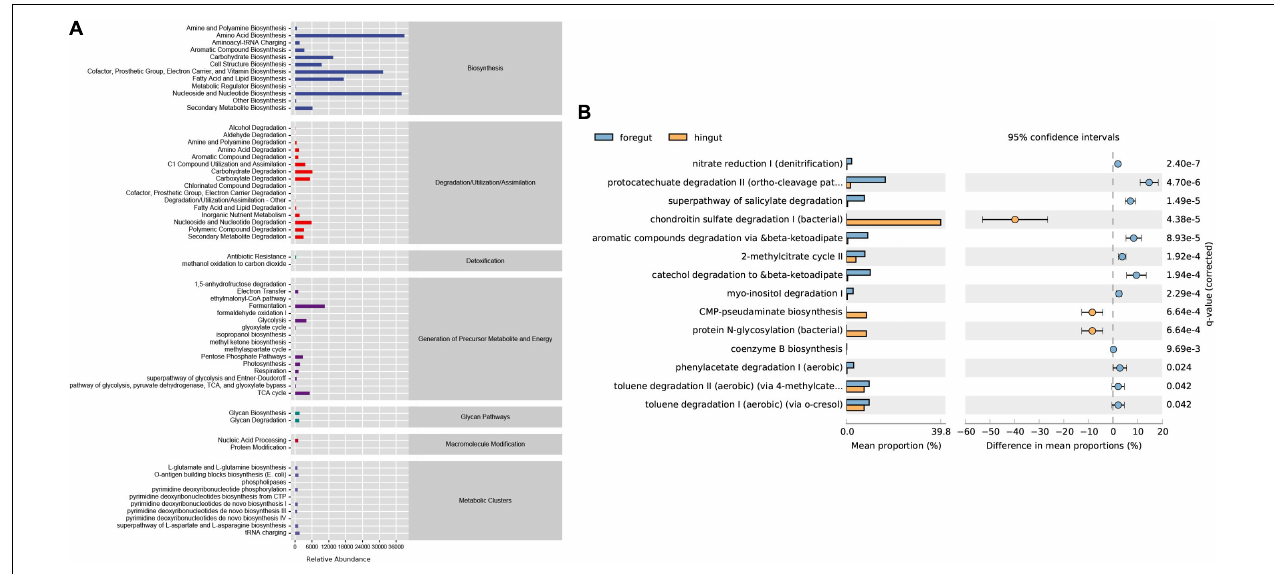
FIGURE 5 | Predictive analysis and statistics of foregut and hindgut microbial function. (A) The abundance of the differential metabolic pathways based on the MetaCyc database. The abscissa is the abundance count of the classification, the ordinate is the functional pathway of MetaCyc’s second classification level, and the rightmost is the first-level classification to which this pathway belongs. (B) The differential analysis of metabolic pathways based on the metagenomeSeq method. Light blue represents the foregut and light yellow represents the hindgut. The right ordinate is the corrected q -value and the left ordinates are different pathway